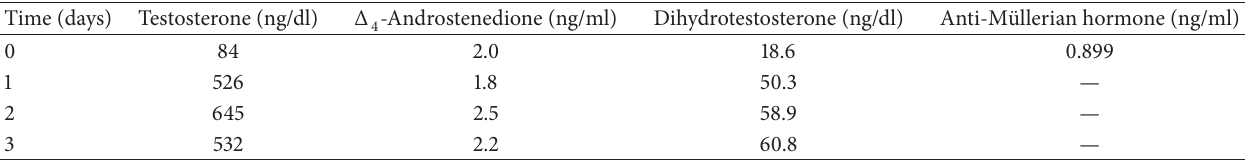
Table 2: hCG stimulation test in case 1.